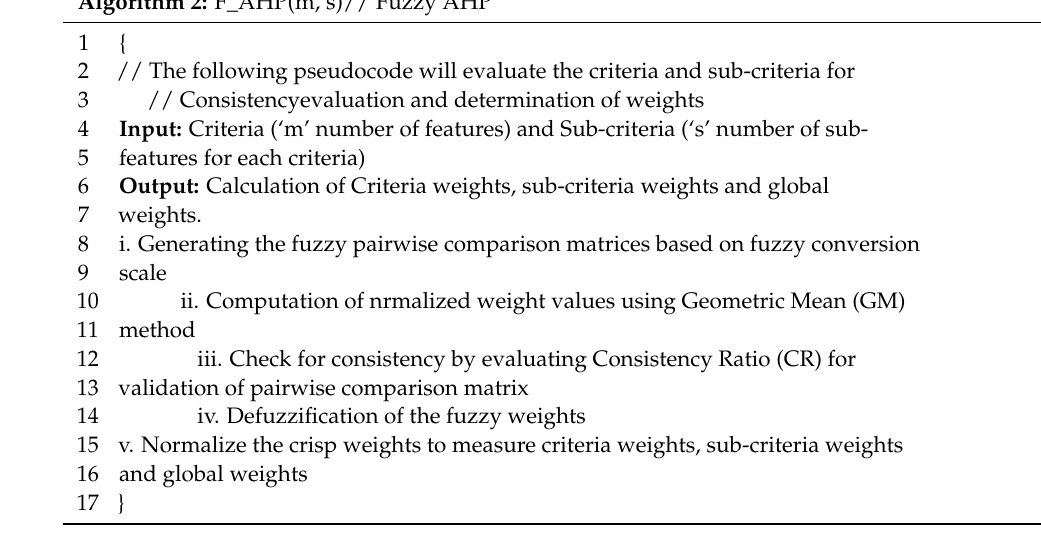
Algorithm 2: F_AHP(m, s)// Fuzzy AHP